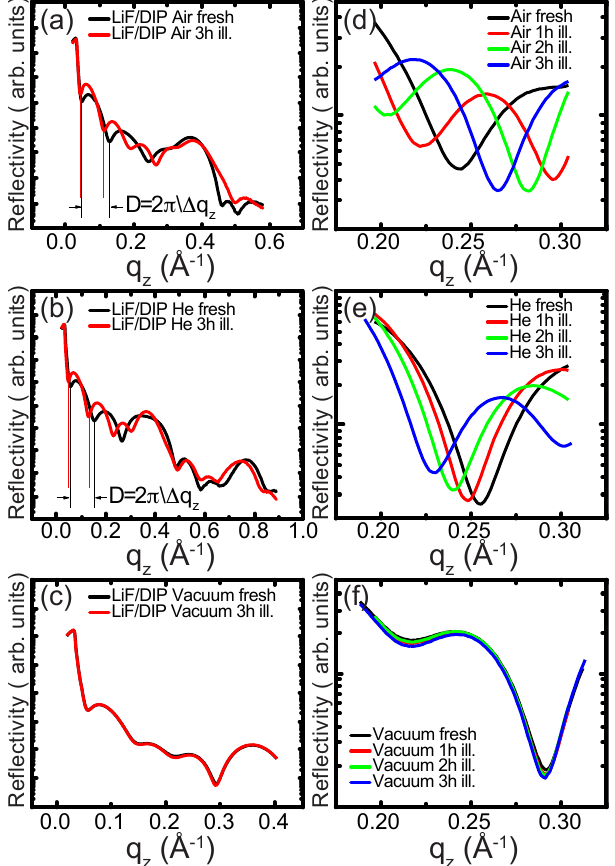
Figure 2. The X-ray reflectivity of three different LiF/DIP bilayer systems under ( a ) air, ( b ) helium, and ( c ) vacuum conditions before and after illumination. ( d – f ) Magnified view of the first Kiessig oscillation minima after 1, 2, and 3 h 10 keV X-ray illumination for each sample. Stable signals were only obtained under vacuum